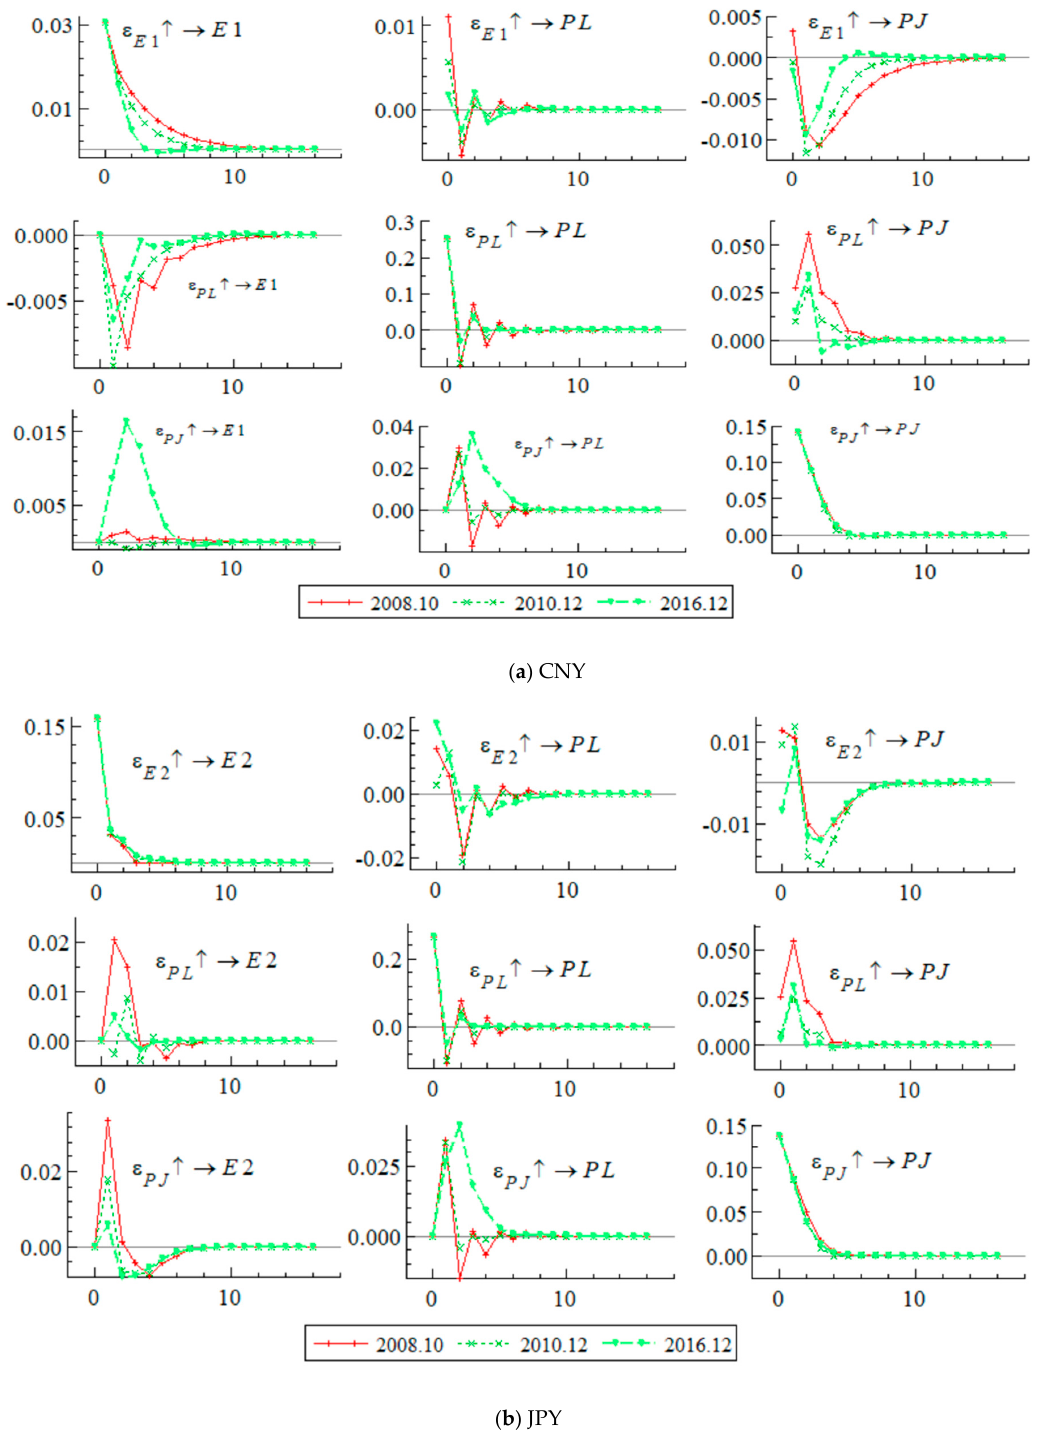
Figure 4. Posterior mean of impulse response functions.